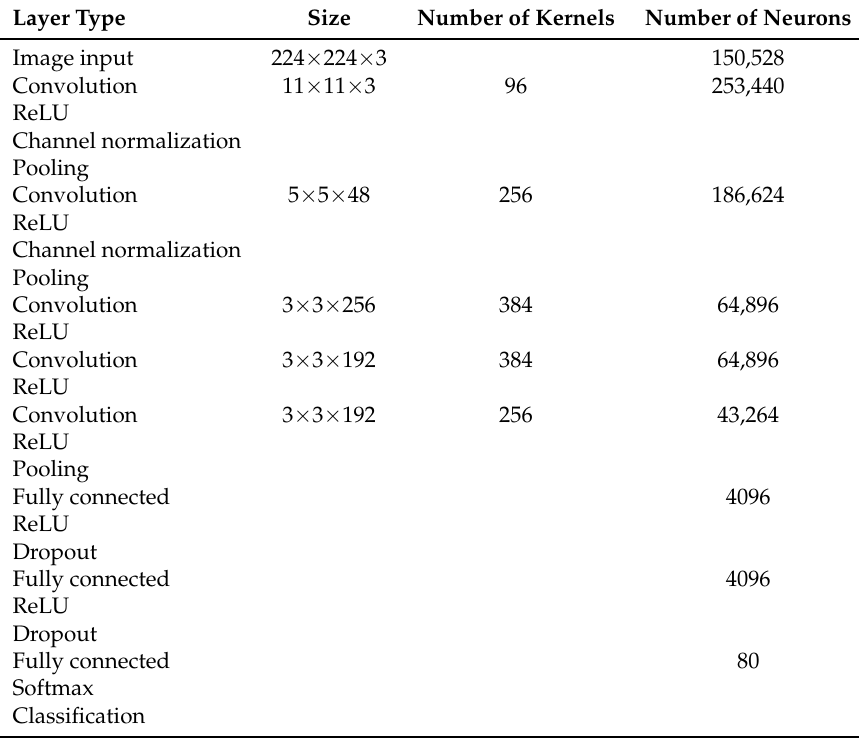
Table 3. AlexNet architecture